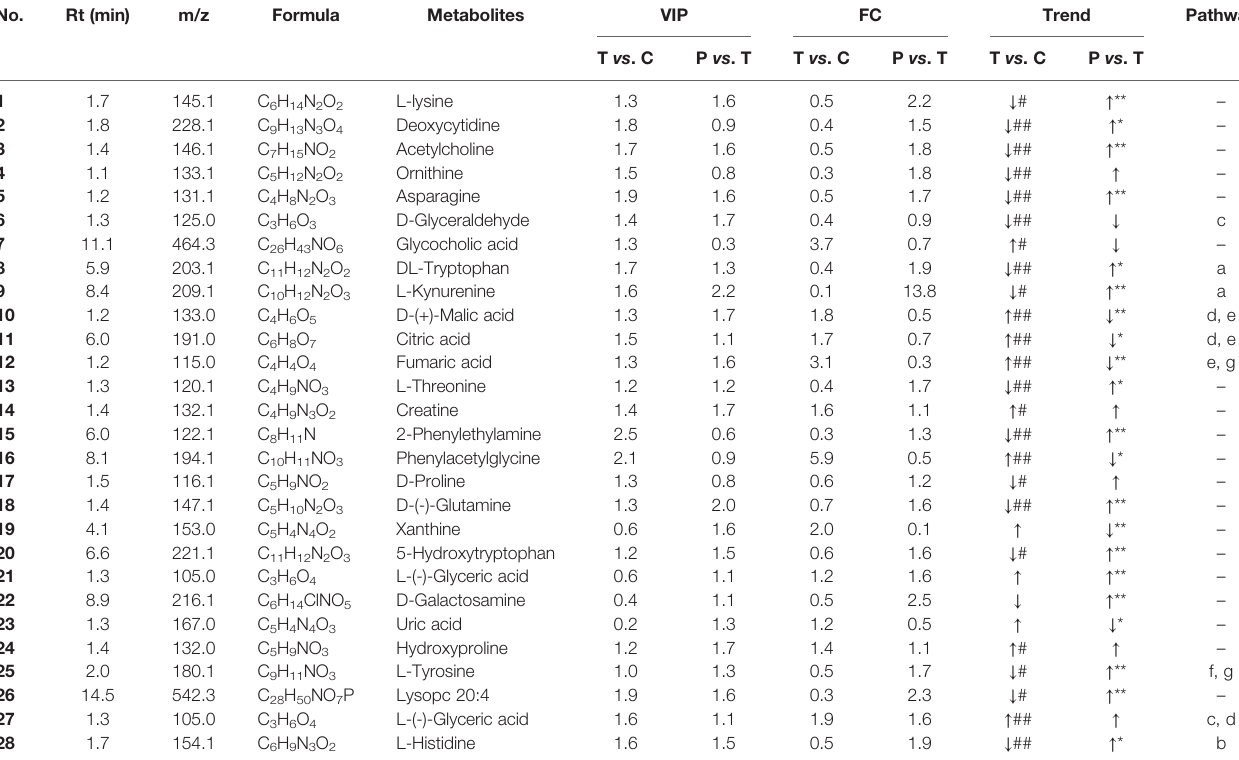
TABLE 5 | The differential metabolites in serum after PDJQ